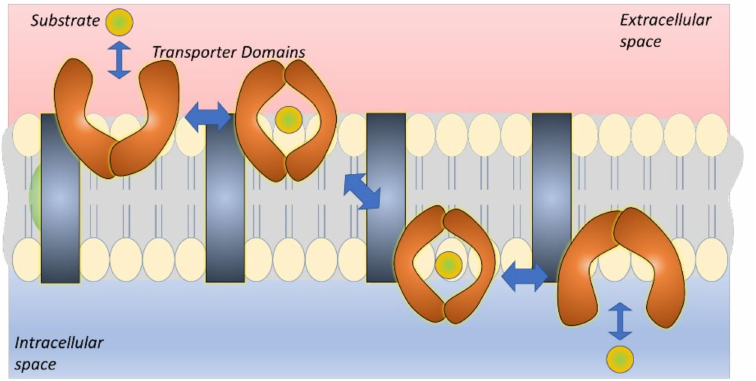
Figure 3. The elevator-type transport mechanism of EAATs and ASCTs. The substrate (green ball-shape) is bound to the transporter on the extracellular side of the plasma membrane. The conformational movements of the transporting domains (orange banana-shapes) close the “gate”, which is followed by vertical translocation of this complex in relation to the static domain (blue). Finally, the second conformational movement opens the “gate” and releases the substrate into the cytosolic